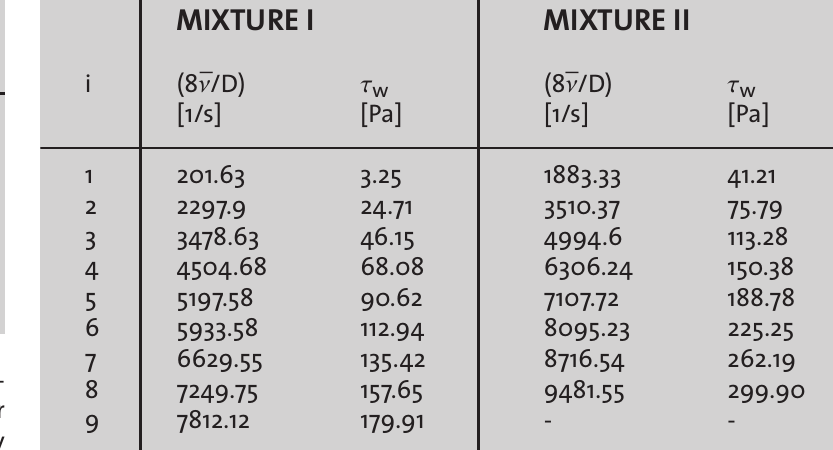
Table 1 (left): Size distribution. Table 2 (right): Results of experiment.